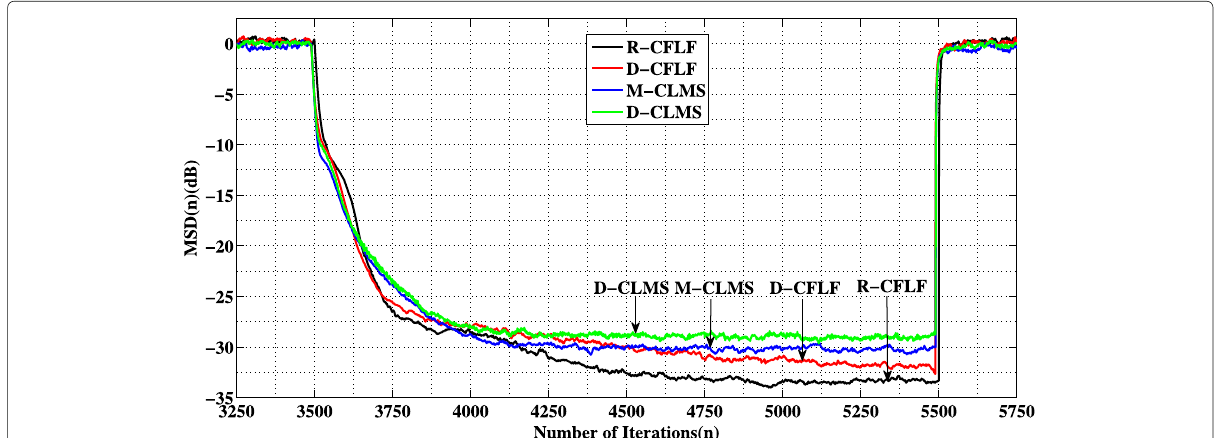
Fig. 15 MSD comparison of the proposed schemes with those of the M-CLMS and D-CLMS schemes when input signal is white